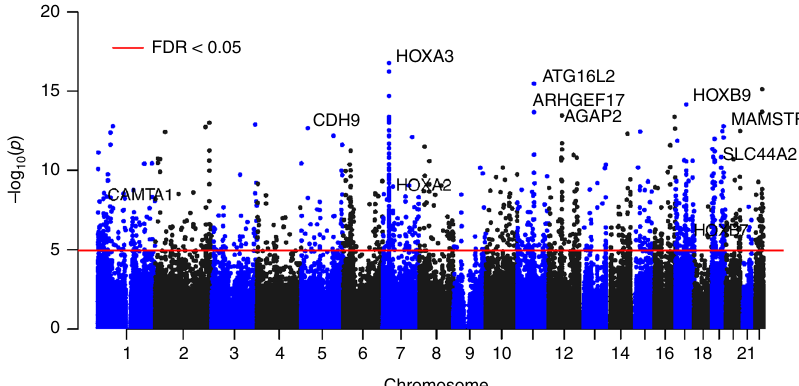
Fig. 2 Manhattan plot of signi fi cant methylation differences in individual CpGs and DMRs identi fi ed in meta-analysis using inverse-variance weighted regression models. The X -axis indicates chromosomes 1 – 22 and the Y -axis indicates − log 10 ( P -value), with the horizontal red line indicating a 5% FDR (false discovery rate) adjusting for multiple comparisons.